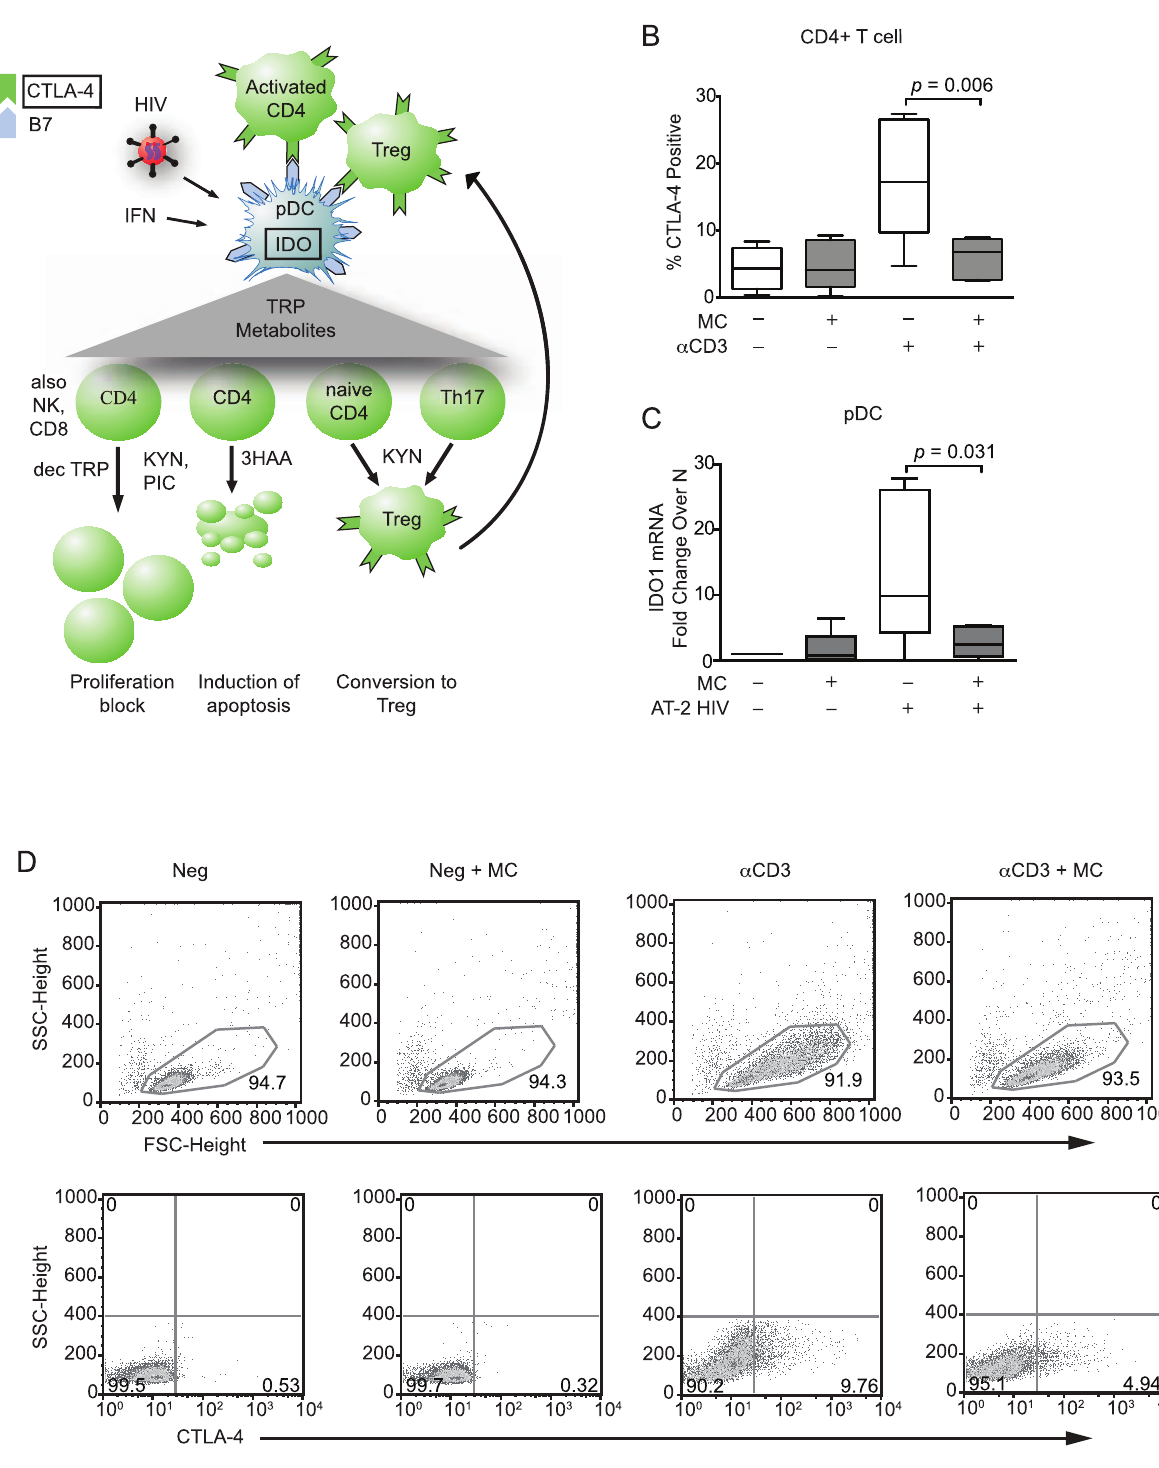
Figure 3. Minocycline prevents CTLA-4 and IDO expression in CD4 + T cells and pDCs. ( A ) IDO can be induced in pDCs by engagement of B7 receptors with CTLA-4 on CD4 + T cells or by stimulation with IFN a , b , c , TNF a , TGF b , or HIV. IDO converts the amino acid tryptophan (TRP) into L- formylkynurenine, initiating the production of a cascade of TRP metabolites that block T cell proliferation, induce T cell apoptosis, and convert CD4 + cells into Tregs. KYN: kynurenine; PIC: picolinic acid; TRP: tryptophan; 3HAA: 3-hydroxy anthranilic acid. ( B ) CD4 + T cells were isolated from blood of healthy human donors and activated with anti-CD3 with or without 20 m M minocycline ( n =6 different donors). After 24 hours minocycline was replenished and some wells were stimulated with IFN a and IFN b . After 48 hours total cells were analyzed by flow cytometry for CTLA-4. ( C ) pDCs were isolated from blood of healthy human donors and exposed to AT-2 HIV with or without 20 m M minocycline ( n =6 different donors). After 18 hours RNA was harvested for IDO1 qRT-PCR. CTLA-4 data were analyzed by paired t -test. IDO mRNA was analyzed by Wilcoxon signed-rank test. ( D ) Representative flow cytometry gating of CTLA-4 expression on isolated CD4 + T cells.